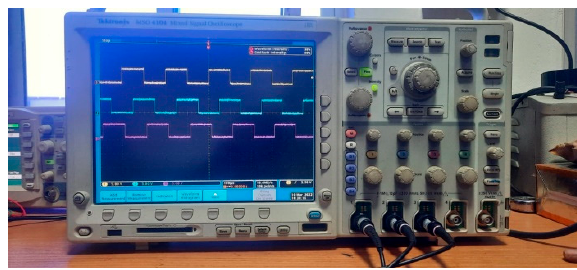
Figure 17. Pulse waveform MPIBC (six phase).